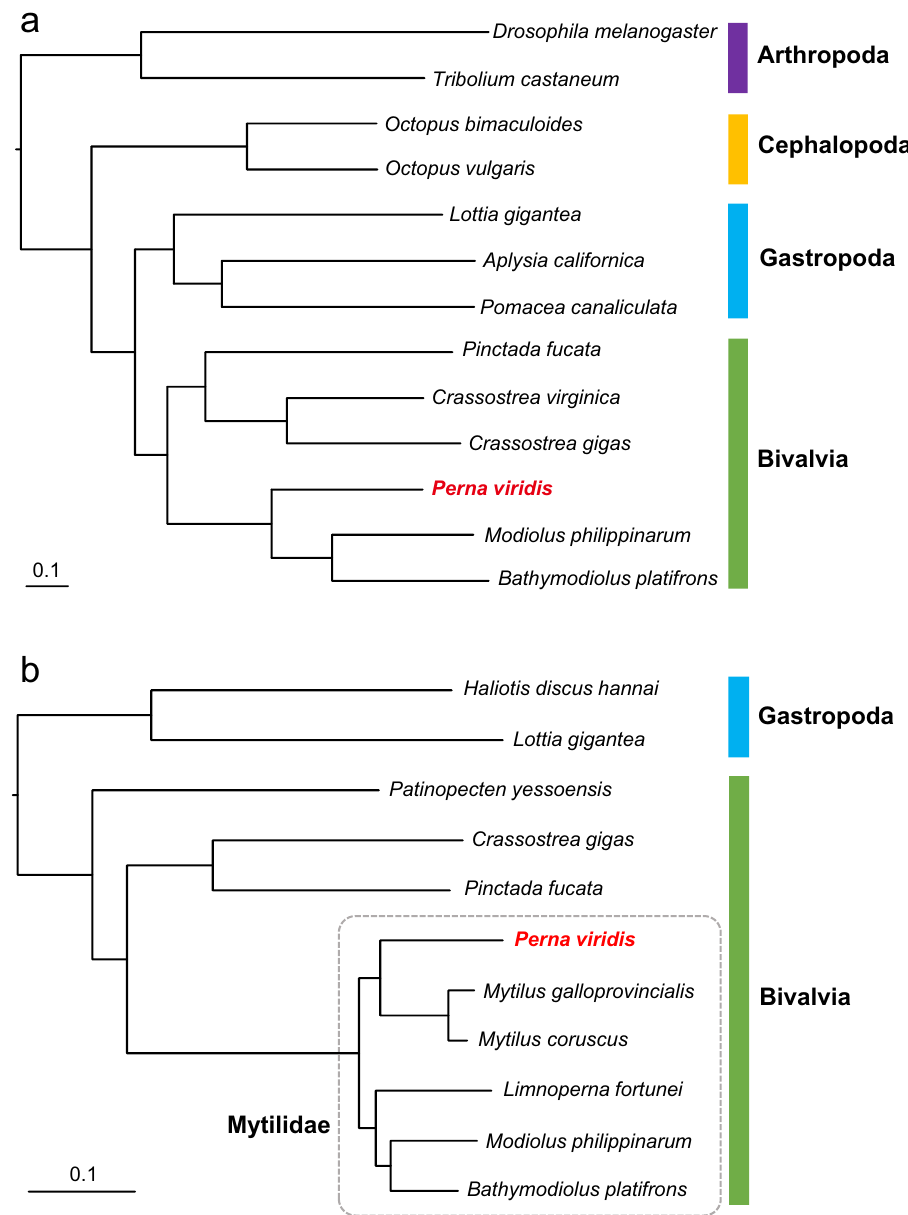
Figure 2. Maximum likelihood (ML) trees of mollusks and bivalves constructed using orthogroups developed from whole-genome sequences. ( a ) phylogenetic tree of mollusks, constructed using 805 genes selected from genome sequences. Tribolium castaneum and Drosophila melanogaster were used as outgroups. (b) phylogenetic tree of bivalves constructed using 153 genes selected from genome sequences. Lottia gigantea and Haliotis discus hannai were used as an outgroup. All nodes have 100% bootstrap support after 100